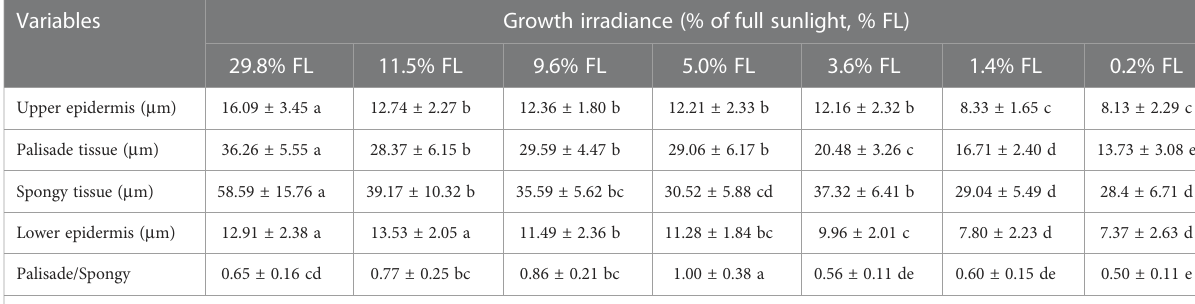
Values are means ± SD. (n = 7). Different letters among light regimes indicate signi fi cant difference (P <